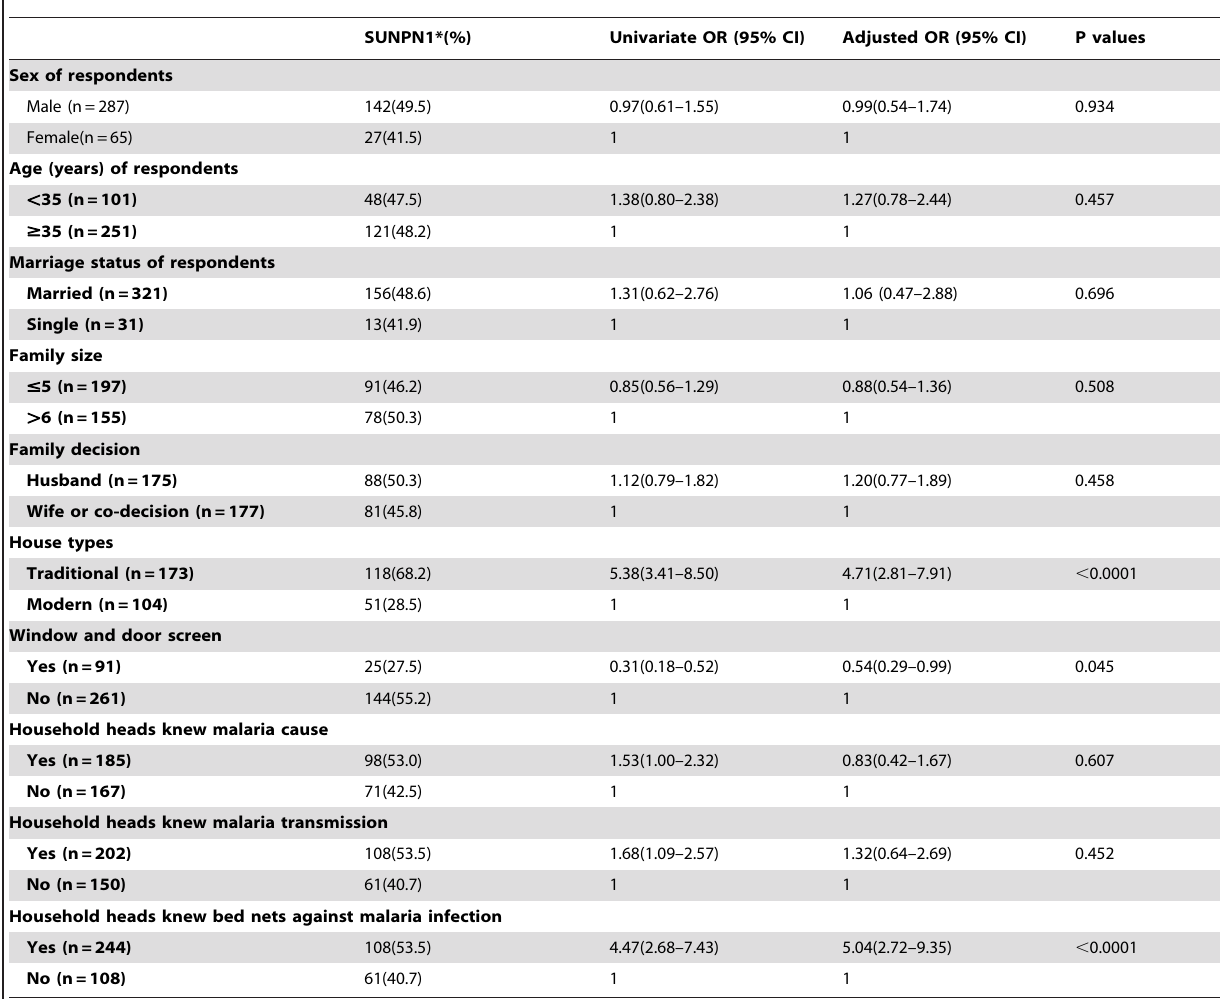
Table 3. Household variables and respondents (Head of Household) related to use of nets in Jinuo ethnic minority, Yunnan,